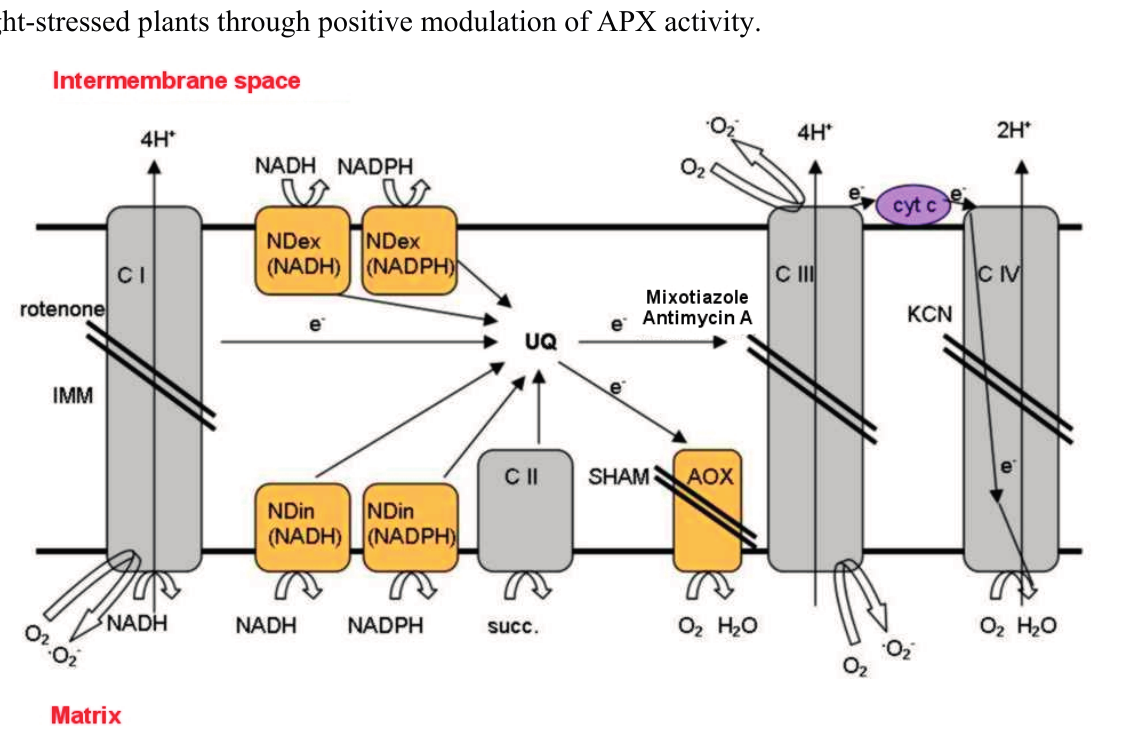
Figure 4. Electron transport chain of the inner mitochondrial membrane of plant